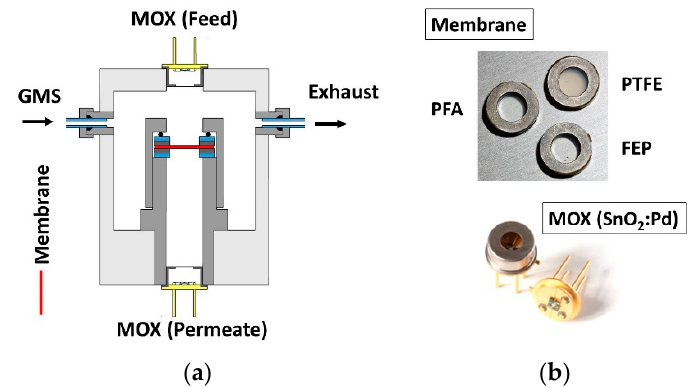
Figure 1. ( a ) Sketch of the measuring chamber consisting of two MOX sensors and a holder for inserting polymer filters; ( b ) Photo of the polymer carriers and the SnO 2 :Pd sensors on TO39